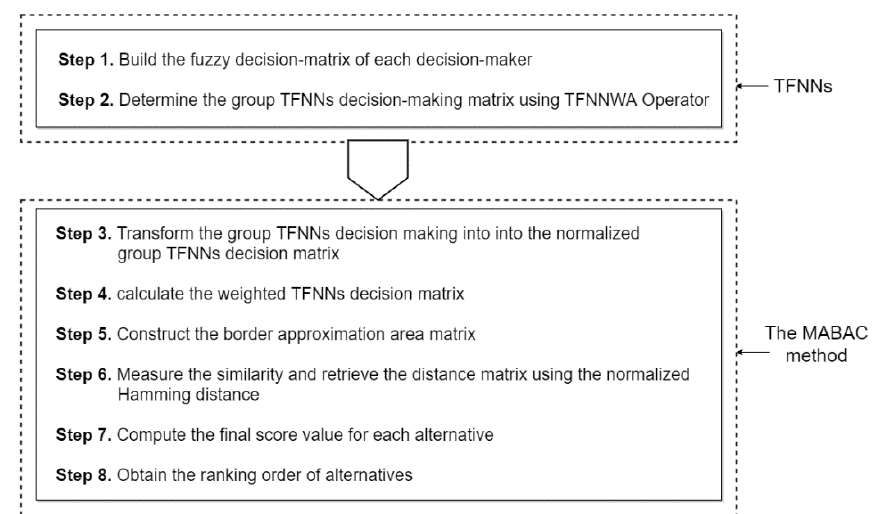
Figure 1. Flow diagram of the calculation procedures for our proposed MABAC method.